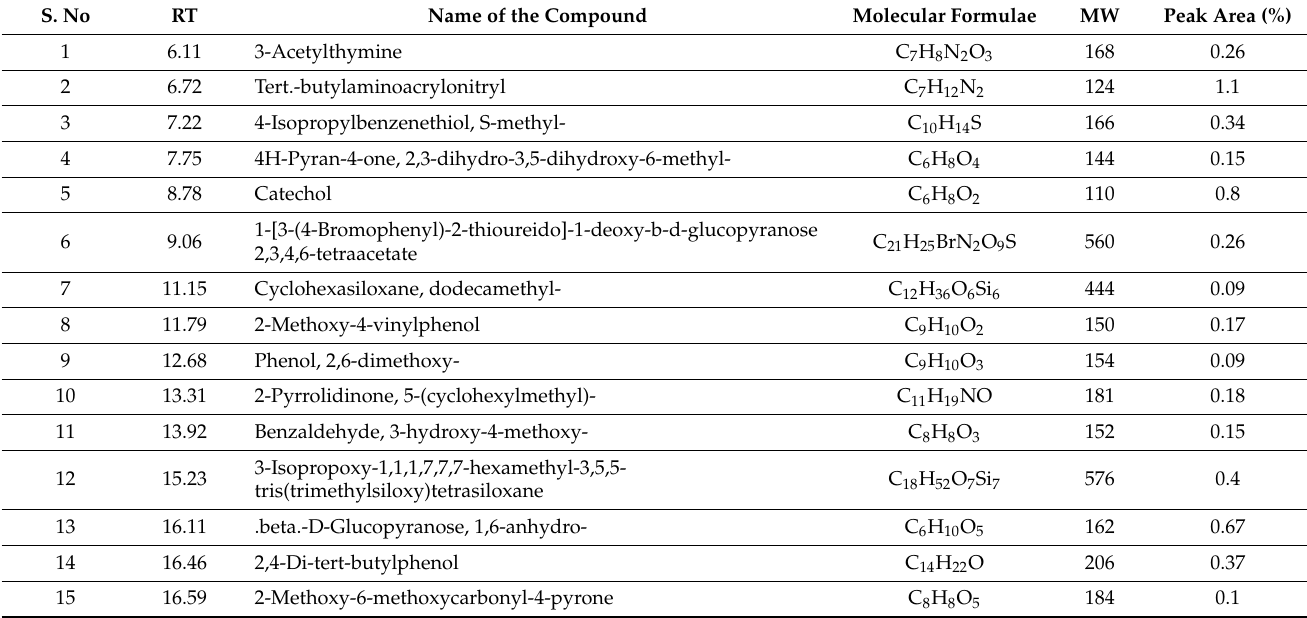
Table 8. Compounds identified in the ethanolic-extracted C. fenestratum